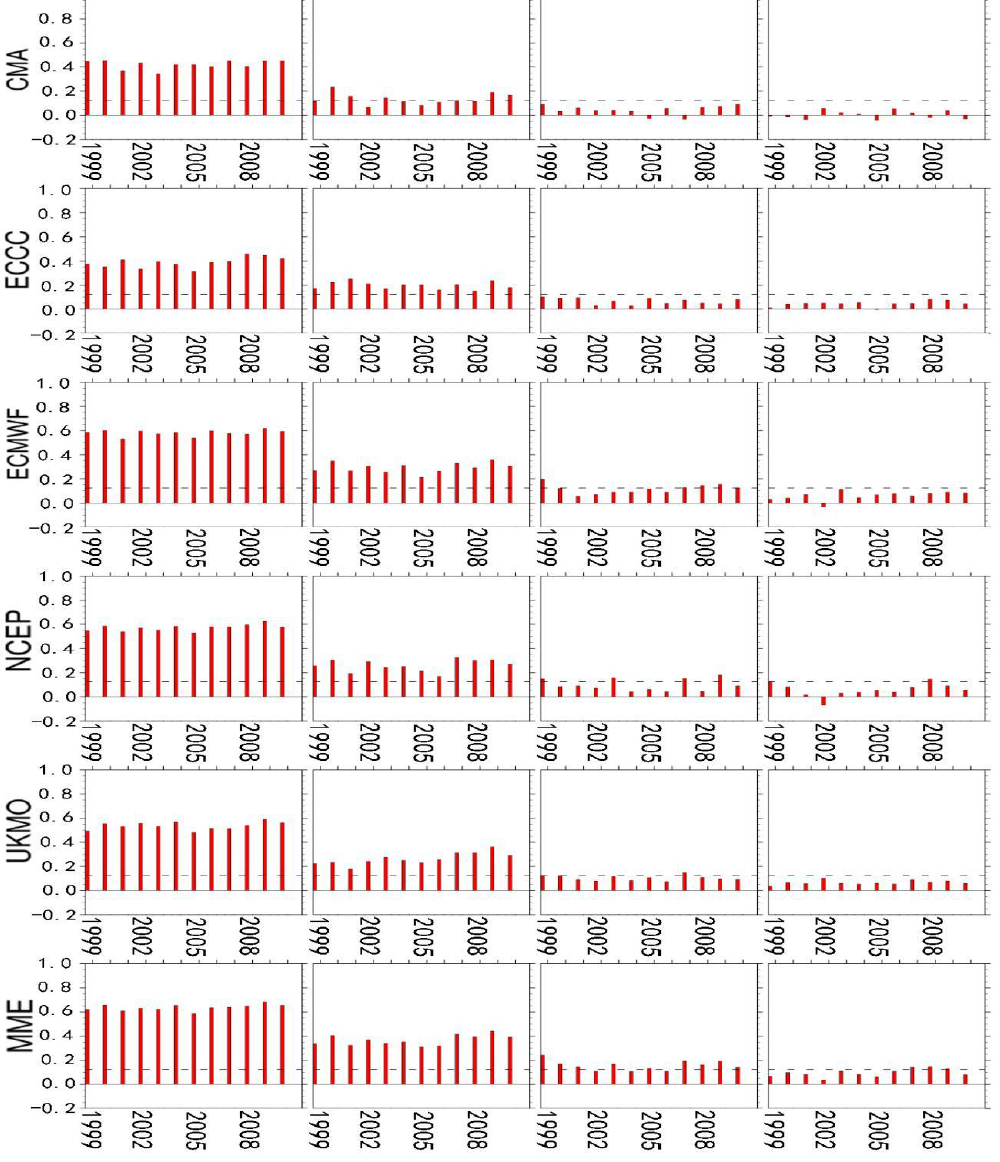
Figure 3. Yearly averaged Pattern Correlation Coefficient (PCC) scores of precipitation anomalies in MJJAS for CMA, ECCC, ECMWF, NCEP, UKMO, and the 15-member MME (from top to bottom). The 1st, 2nd, 3rd, and 4th columns are predictions for lead weeks 1–4, respectively. The dashed black line represents the 95% significance threshold.